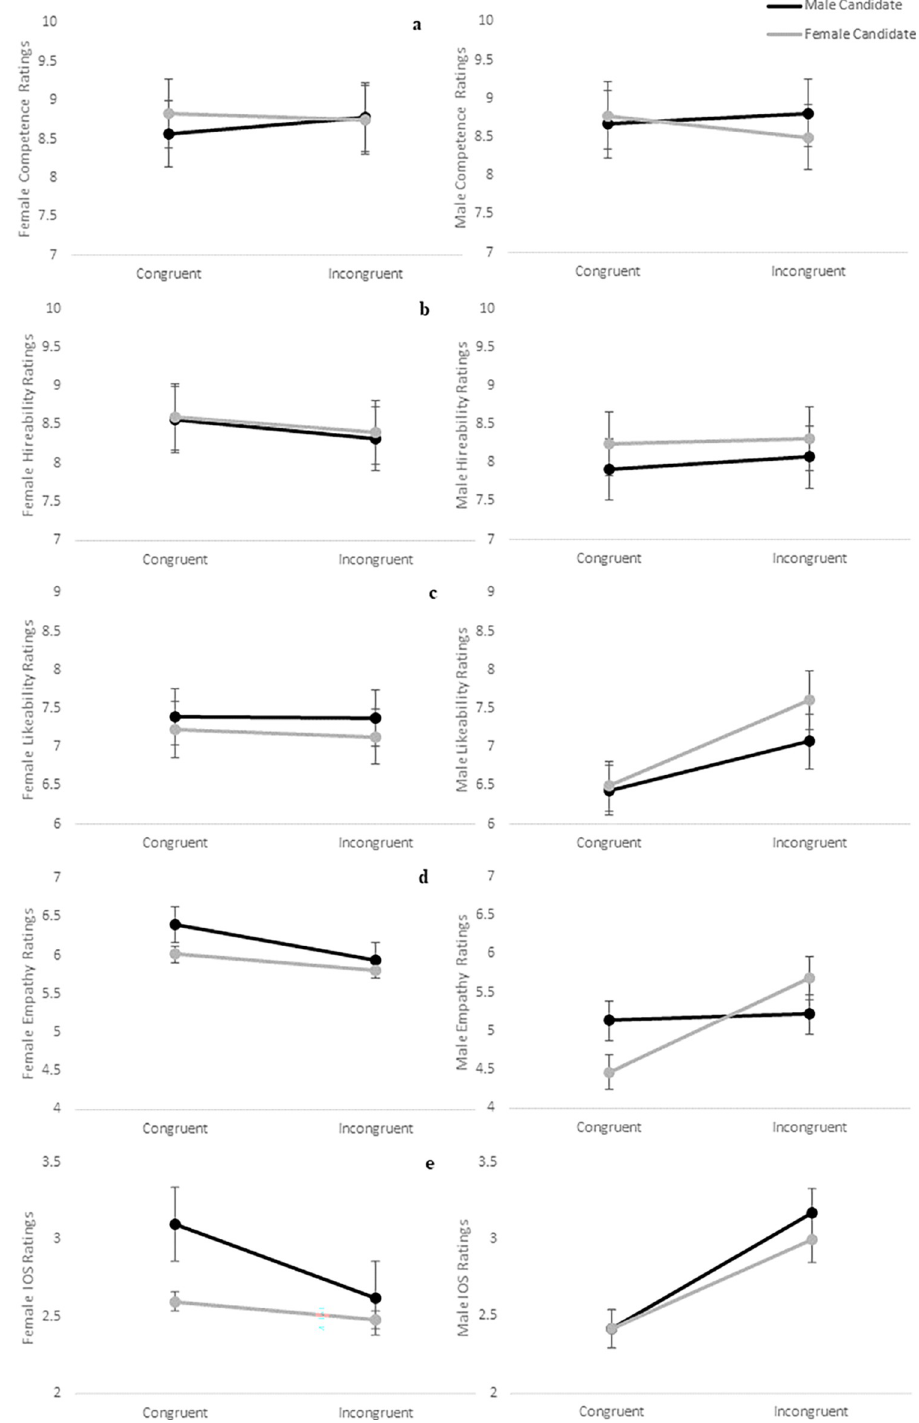
Fig 3. Candidate ratings following online perspective taking. Comparison of female (left) and male (right) participant ratings by embodiment for the virtual candidates as illustrated for a) competence; b) hireability; c) likeability; d) empathy; e) interpersonal closeness.